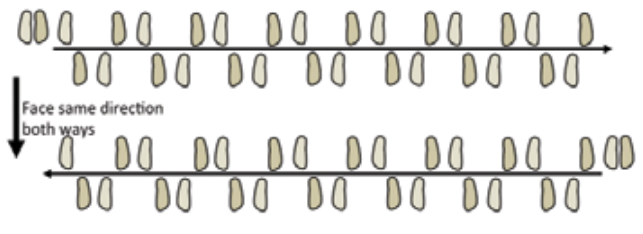
Figure 5-32. Line Jump Routine – Ali Shuffle